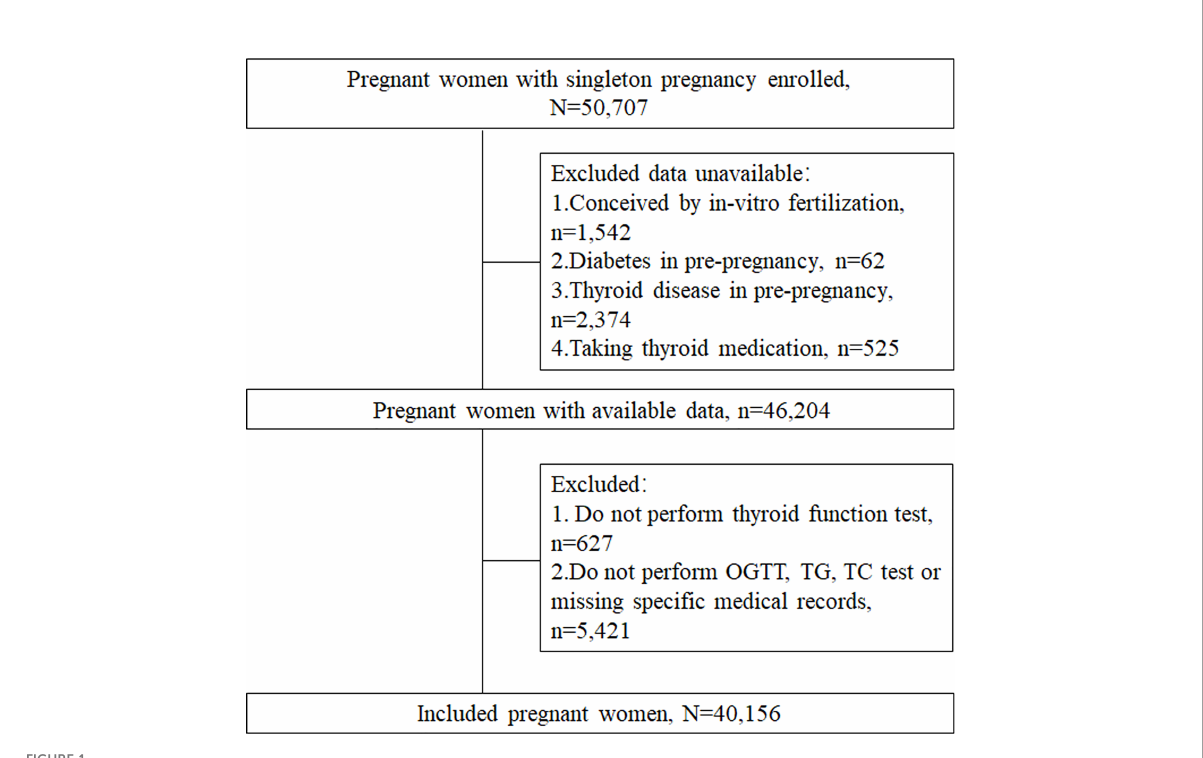
FIGURE 1 Flowchart of the participants included in the